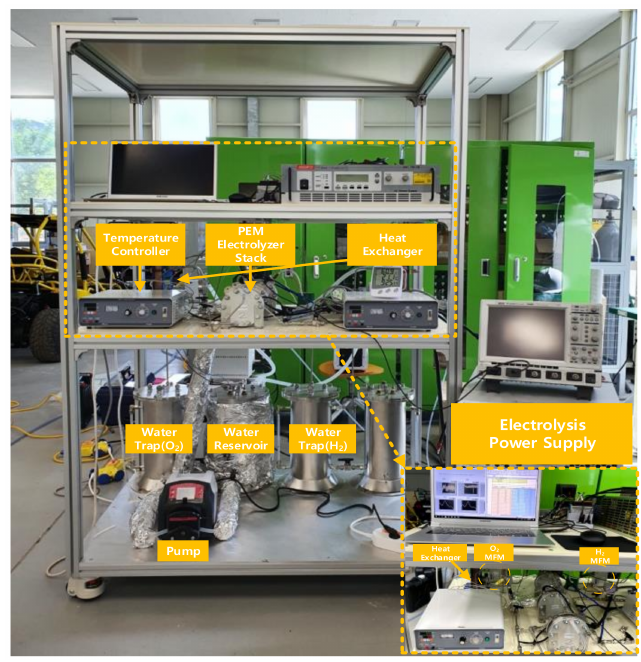
Figure 13. A PEM electrolysis